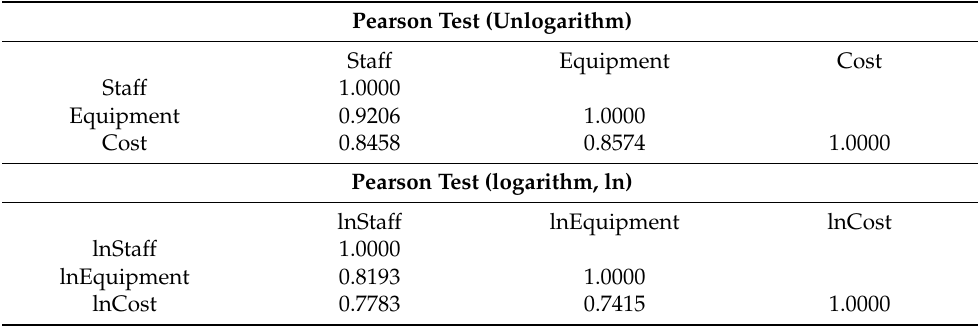
Table 3. Correlation test